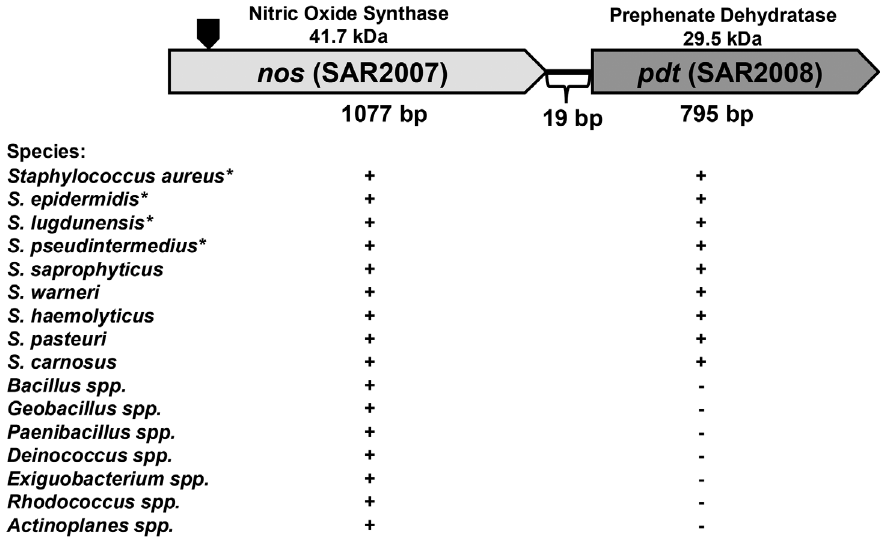
Figure 1. Genetic arrangement of the S.aureusnos and pdt genes. The representative bacterial genera and/or species that contain a nos gene are listed below the S. aureus nos-pdt operon diagram. The ‘‘ + ’’ designation under nos indicates its presence in each respective genome, whereas the ‘‘ + / 2 ’’ designation under pdt indicates if this gene is located immediately downstream of nos in each respective bacterial genera/species. The predicted molecular weight (kDa) of the nos and pdt ORFs are indicated above each gene, and the size (bp) of each gene is shown below. Gene designations refer to the MRSA252 genome. The site where the erm resistance cassette was inserted to create the nos :: erm mutant (KR1010) is indicated by the black block arrow. *denotes that all sequenced strains in NCBI contain the indicated genes.